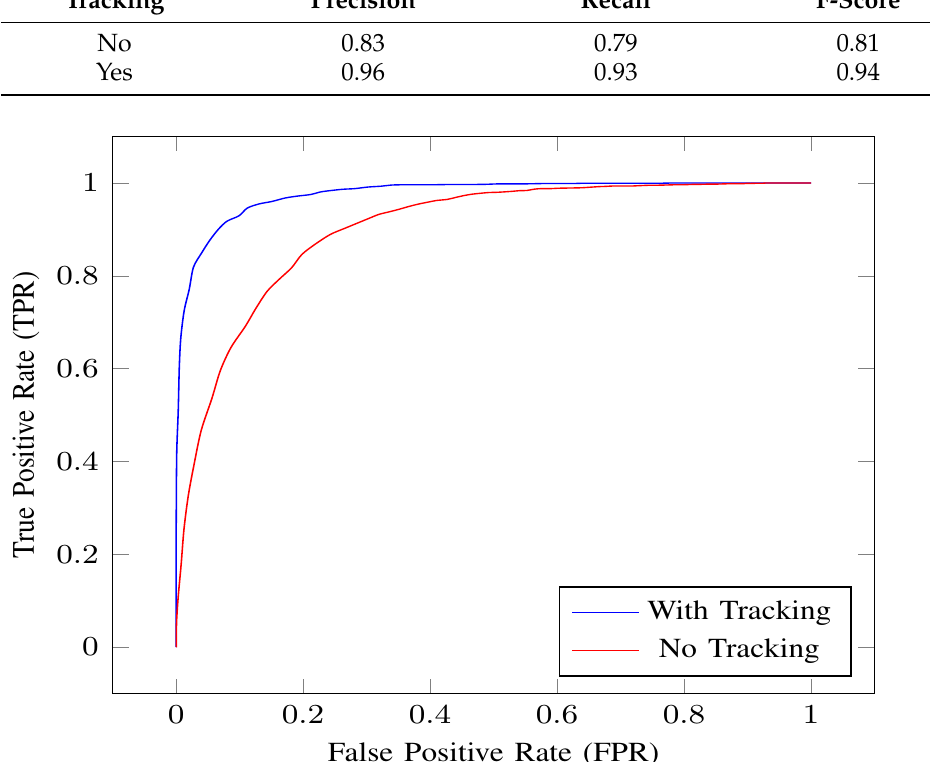
Table 1. The average results of precision, recall, and F-score on ChokePoint dataset. Tracking Precision Recall